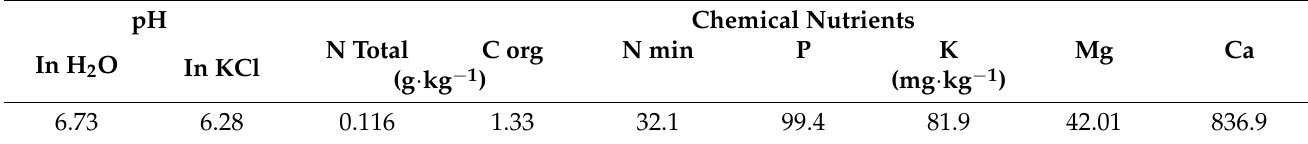
Table 1. Chemical properties of the experimental soil. Adapted from Kubo´n